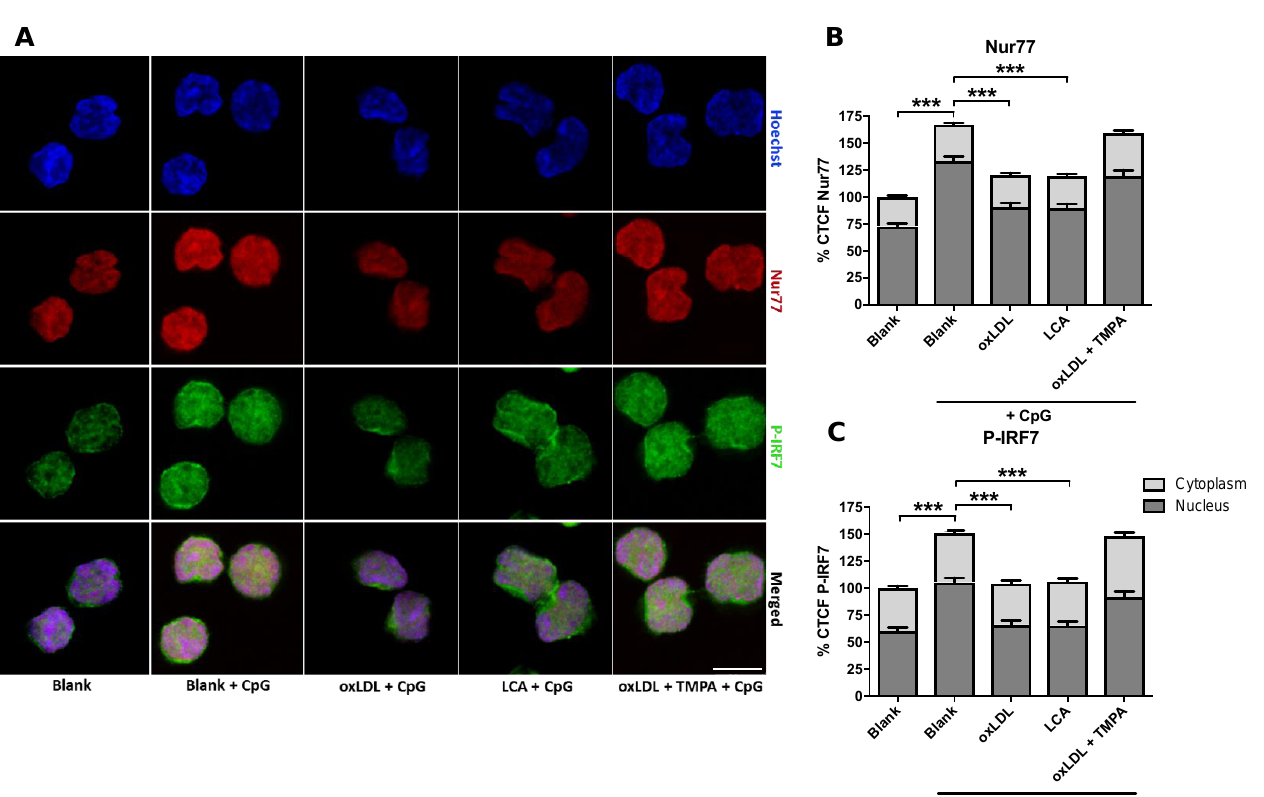
Figure 6. oxLDL (25 µg/mL), NUR77 agonist lithocholic acid (LCA, 20 µM) and/or NUR77 antagonist ethyl 2-[2,3,4-trimethoxy-6-(1-octanoyl)phenyl] acetate (TMPA, 20 µM). Non-stimulated pDCs were used as control. The cells were stained for IRF7. ( A ) Representative images of pDC phospho-IRF7 (green) and NUR77 expression (red); nuclei are counterstained by Hoechst 33342 (blue). ( B , C ) Quantification of the corrected total cell fluorescence (CTCF) for p-IRF7 and NUR77 staining revealed a marked inhibitory effect of oxLDL on CpG-mediated Ser471/2 phosphorylation of IRF7; this effect could be mimicked by Nur77 agonist LCA and rescued by co-treatment with the Nur77 ligand-binding domain antagonist TMPA. *** p < 0.001.